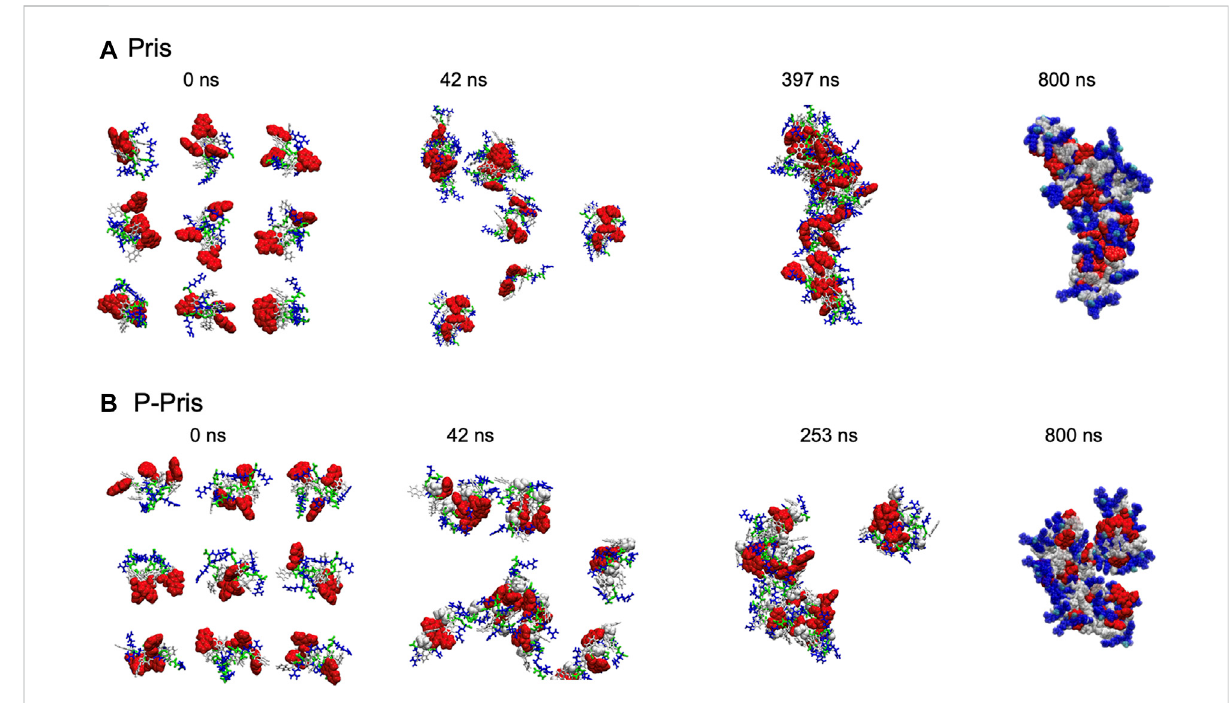
FIGURE 3 Priscilicidin (A) and P-Priscilicidin (B) molecular dynamics